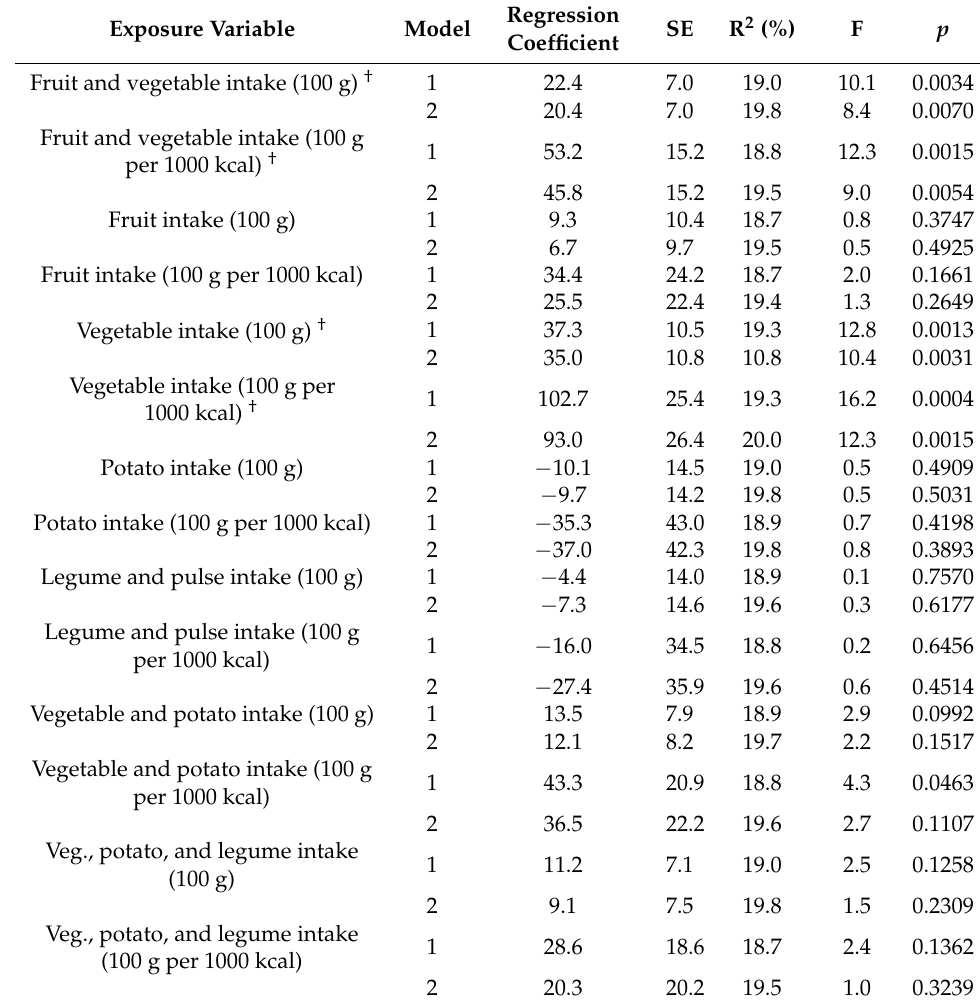
Table 4. Relationship between fruit and vegetable intake and telomere length in U.S. men